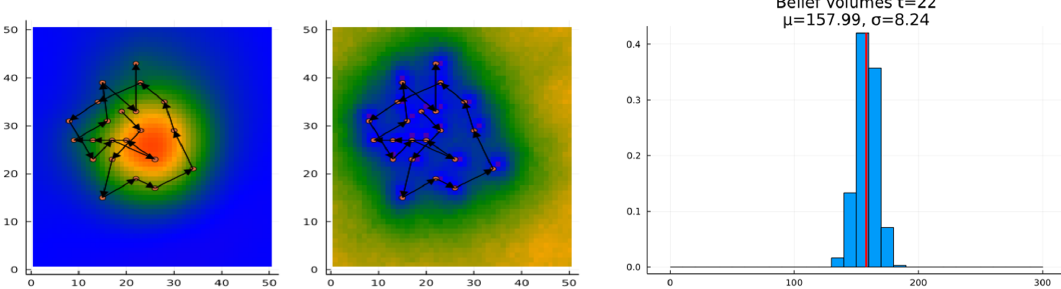
Figure 10. Complete measurement trajectory. The panel on the left shows the complete trajectory of all measurements taken in the illustration case. The panel on the right shows the resulting histogram.